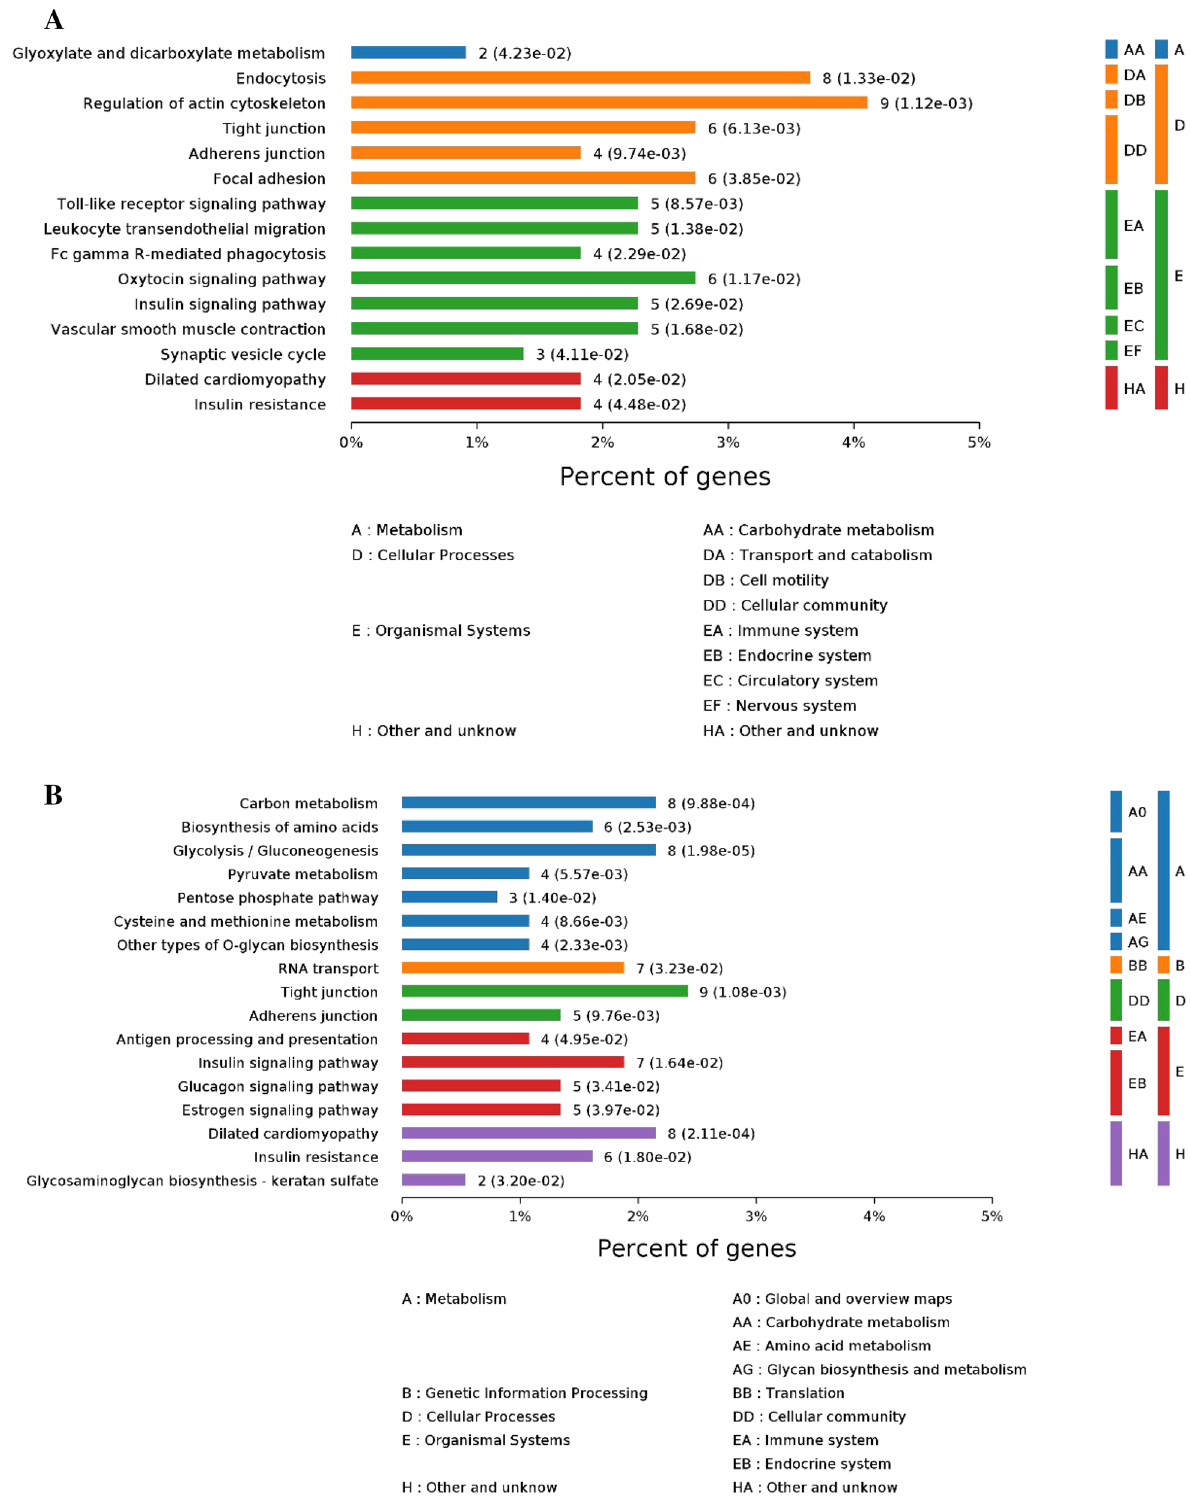
Figure 2. ( A ) Enriched KEGG pathways associated with the comparison of Yushu 12 h versus Gannan 12 h samples. ( B ) Enriched KEGG pathways associated with the comparison of Yushu 72 h versus Gannan 72 h